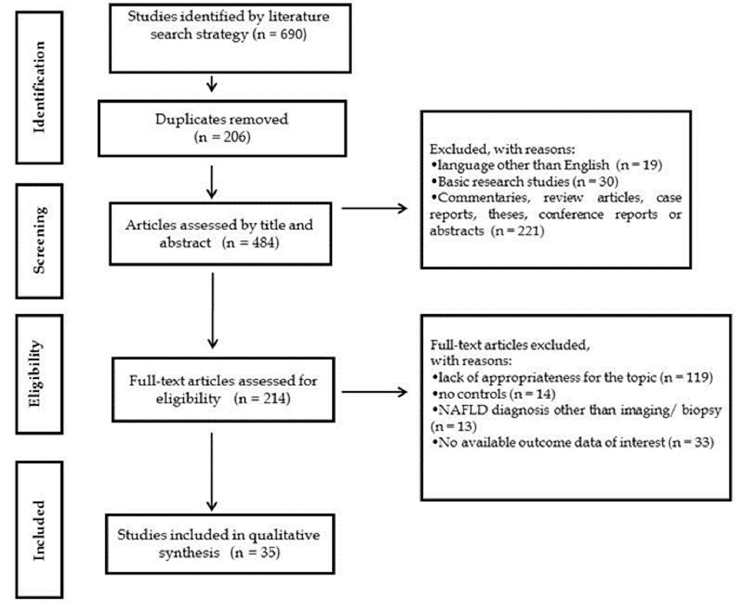
Figure 2. Flow diagram of the study selection process.